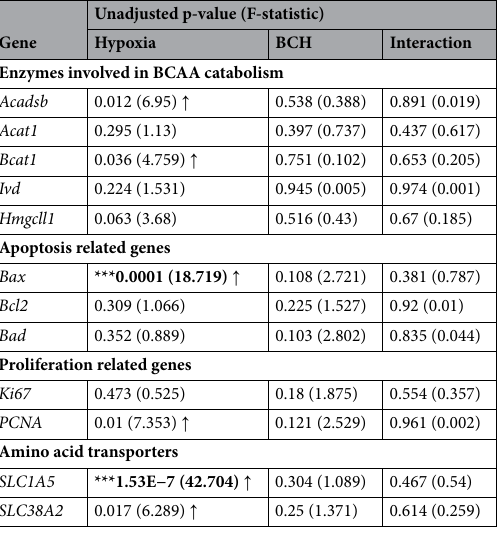
Table 2. List of candidate gene expression effects including their unadjusted p-value and F-statistic for main effects of hypoxia and BCH, as well as an interaction effect. Arrows indicating direction of change are present for all comparisons with p < 0.05. Values in bold remain significant after correction for multiple comparisons. *** indicates p < 0.001.